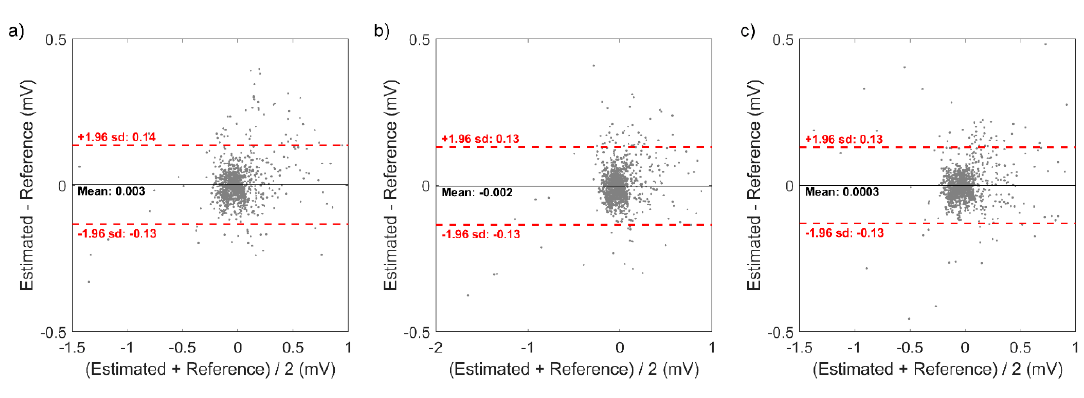
Figure 4. CC and root mean square error (RMSE) values of the electrode combination that showed the highest CC for each shape.